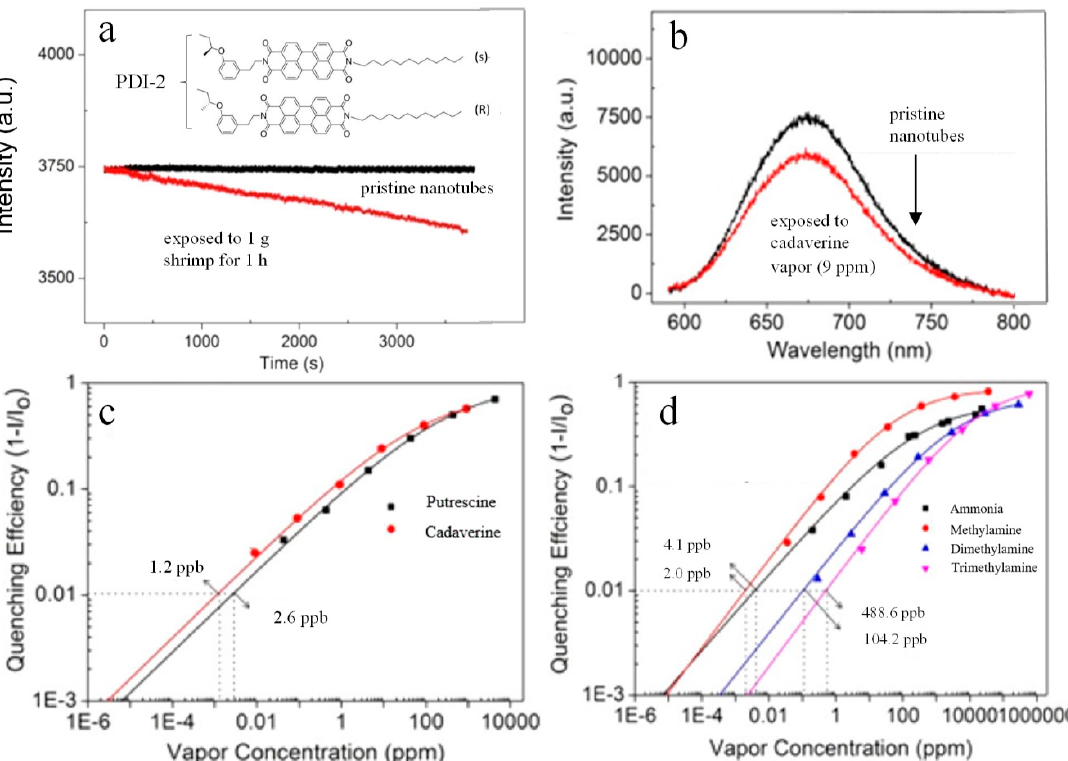
Figure 4. ( a ) Fluorescence intensity recorded for the nanotubes assembled from PDI-2 as a function of time at room temperature (25 °C) for 1 h, for both the pristine sample (black) and the one exposed to 1 g shrimp placed in a 1 cm proximity (red). Inset shows molecular structures of chiral molecule PDI-2; ( b ) Typical fluorescence spectra recorded for the PDI-2 nanotubes before and after exposure to 9 ppm cadaverine; ( c ) Fluorescence quenching efficiency (1-I/I o ) of the nanotubes as a function of the vapor concentration of cadaverine and putrescine, as well as ( d ) other amines [61].